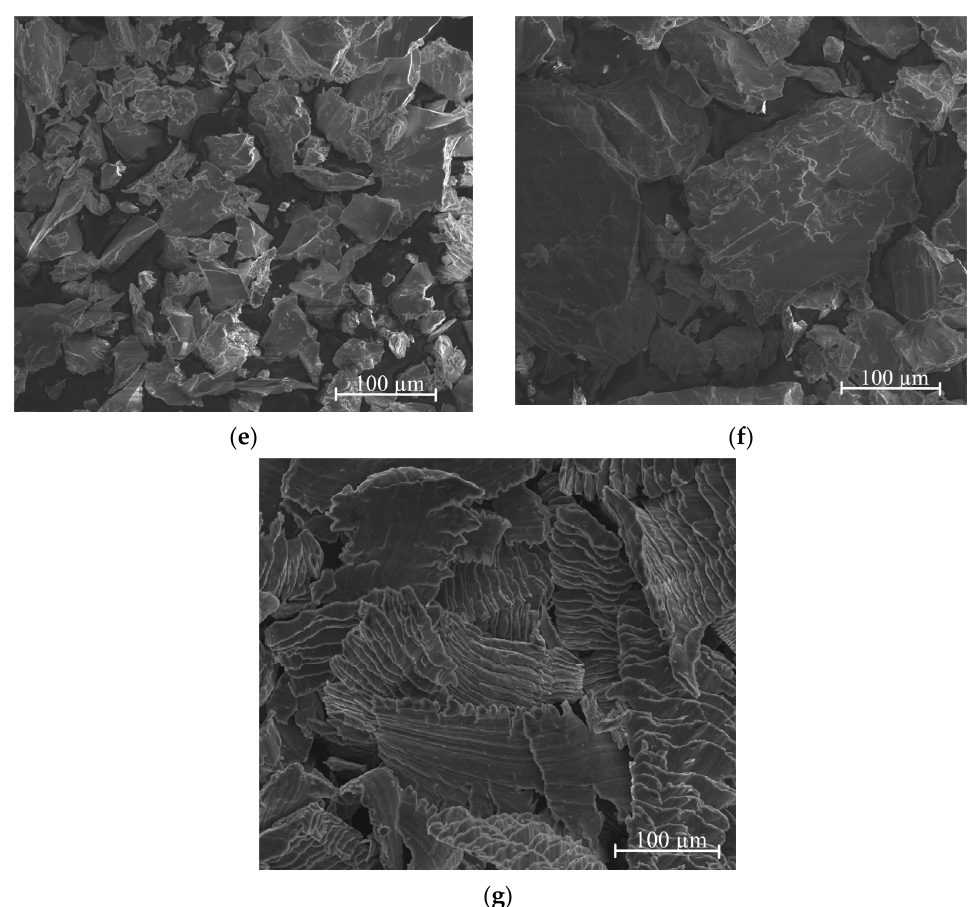
Figure 2. SEM microstructures of various Ag-Mg alloys: ( a ) Alloy 10, ( b ) Alloy 9, ( c ) Alloy 8, ( d ) Alloy 7, ( e ) Alloy 6, ( f ) Alloy 5, and ( g ) Alloy 2.